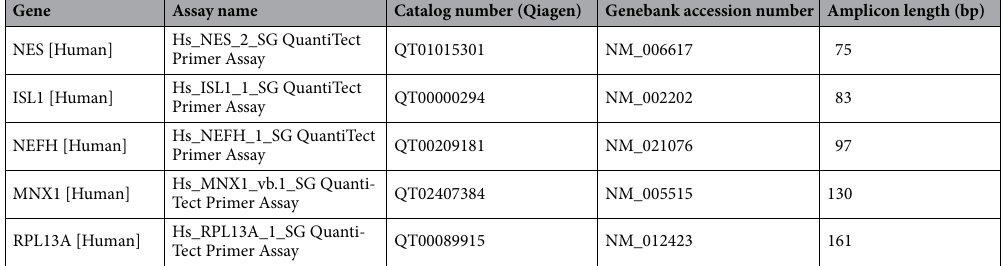
Table 5. Primers used for real-time RT-PCR.